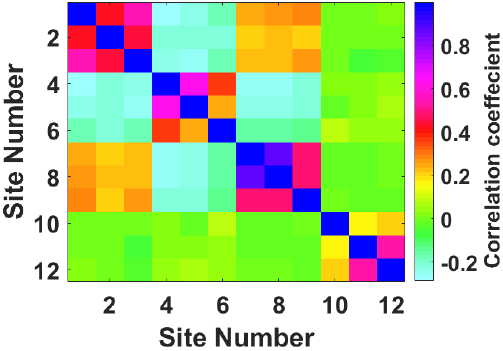
Figure 5. Percentage of annual and semi-annual items in total en- ergy for ZHD biases of the model SAAS D